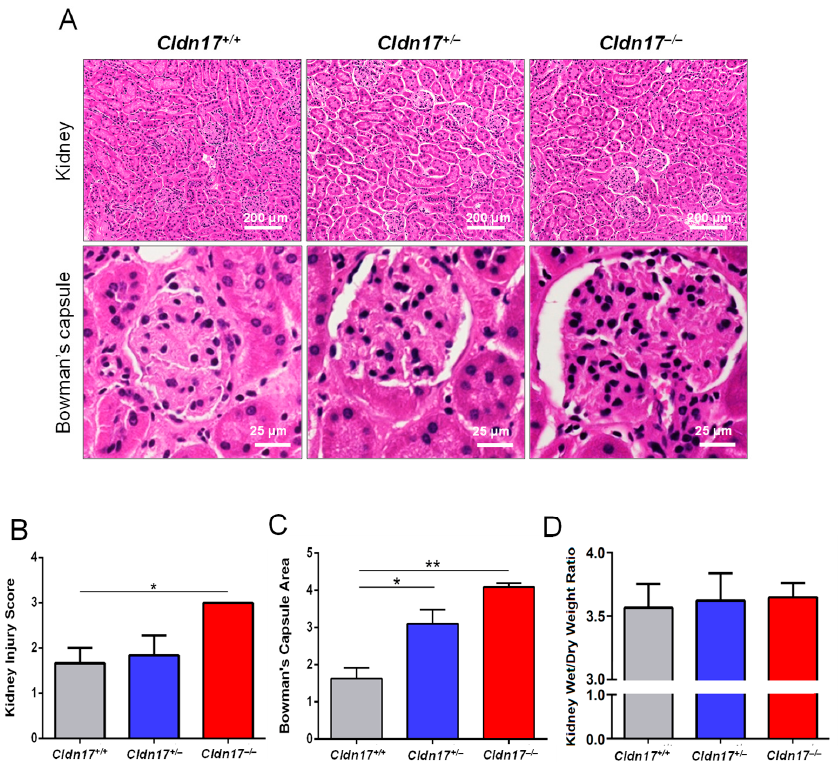
Figure 3. Cldn17 − / − mice display kidney injury. ( A ) Hematoxylin and eosin-stained images of kidneys with magnified Bowman’s capsule area from WT, Cldn17 +/ − , and Cldn17 − / − mice. ( B ) Bar graph showing kidney injury score determined by blinded reviewers and quantification of renal edema by wet/dry ratio. ( C ) Bar graph showing quantification of Bowman’s capsule area by Image J software. ( D ) Bar graph showing quantification of renal edema by wet/dry ratio. n = 3–5; * p < 0.05; ** p < 0.01.